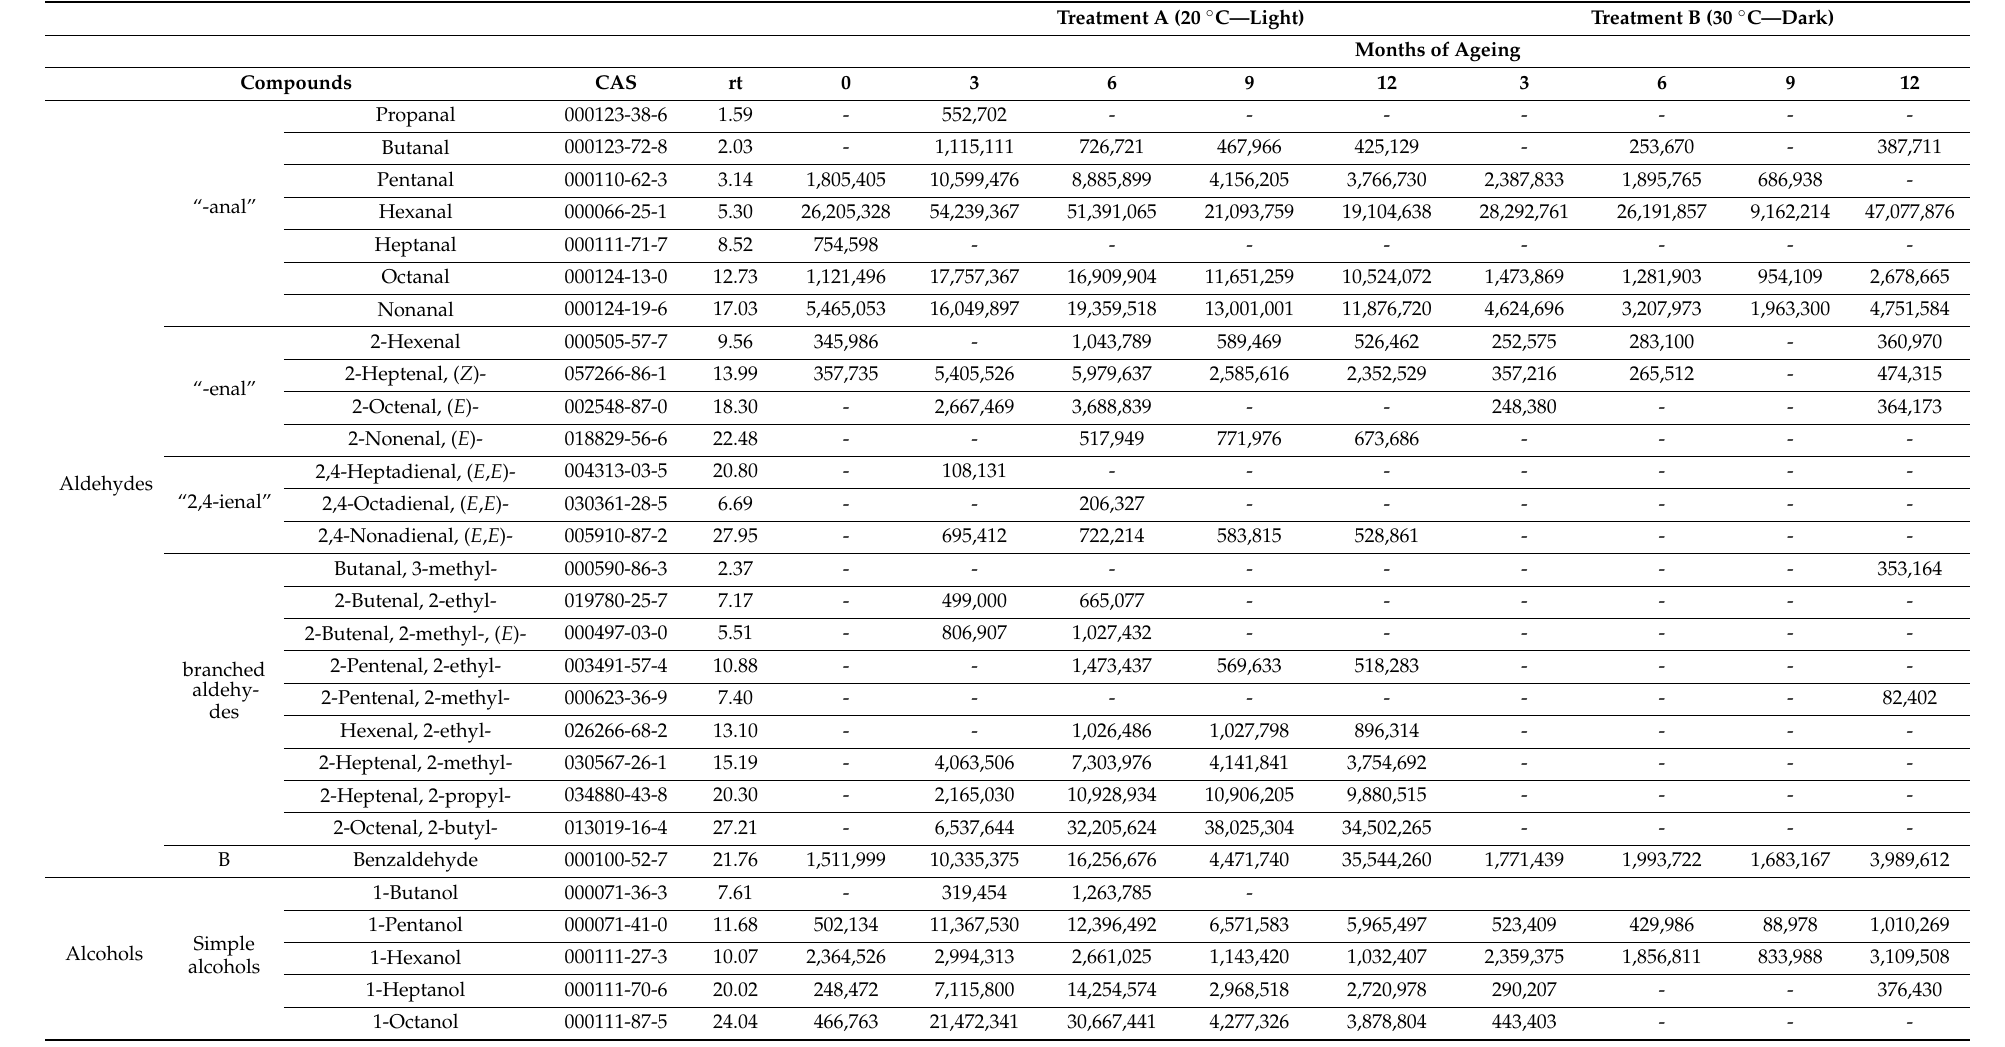
Table A2. Evolution of the volatile compounds during the two treatments, sorted by chemical families, in area/g of sample ( n =